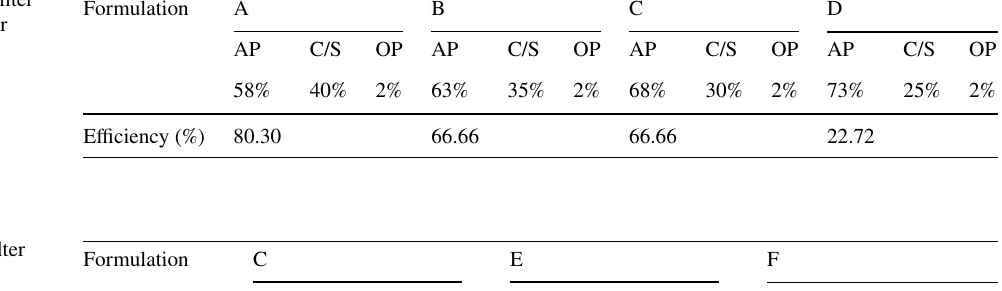
Table 3 Formulation and filter cake removal efficiency for points C, E and F